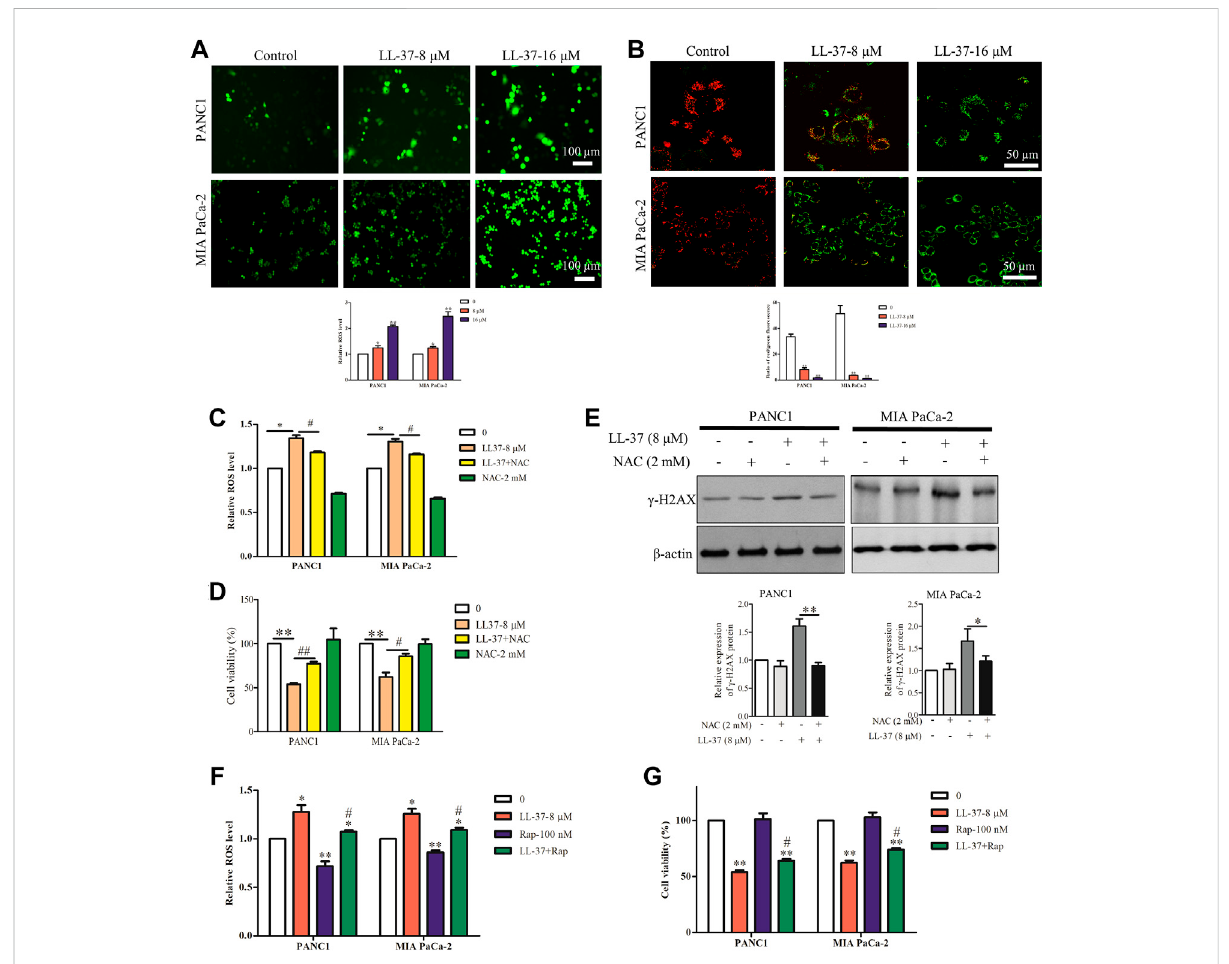
FIGURE 4 LL-37 increases the intracellular production of reactive oxygen species (ROS) in pancreatic cancer cells. (A) ROS were detected using the fl uorescence dye CM-H2DCFDA and immuno fl uorescence microscopy. ROS fl uorescence was measured using a SpectraMax Plate Reader (Molecular Devices) with excitation/emission wavelengths of 495/520 nm. Data are presented as mean ± SD of three independent experiments conducted in triplicate. * p < 0.05, ** p < 0.01 vs . control (0 μ M). (B) Effect of LL-37 on the MMP in PANC1 and MIA PaCa-2 cells was measured using JC-1 staining method. Representative images were photographed under a confocal microscope. The red/green fl uorescence ratio was quanti fi ed by the Image J. ** p < 0.01 vs. control (0 μ M). (C) The ROS production of pancreatic cancer cells treated with LL-37 in the presence and absenceofaROSscavengerNAC(2 mM)wasdetermined. * p < 0.05 vs .control; # p < 0.05 vs .LL-37(8 µM). (D) Theviabilityofpancreaticcancercells treated with LL-37 inthe presence and absence of aROS scavengerNAC was determined using an MTT assay. ** p < 0.01 vs .control; # p < 0.05, ## p < 0.01 vs . LL-37 (8 µM). (E) The expression of γ -H2AX in PANC1 and MIA PaCa-2 cells treated with LL-37 in the presence and absence of NAC was determined by western blotting. Non-arbitrary band density data relative to that of the housekeeping protein ß -actin are presented as mean ±